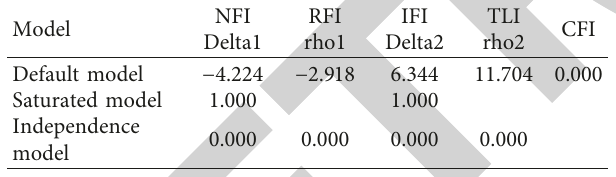
Table 12: Baseline comparisons.